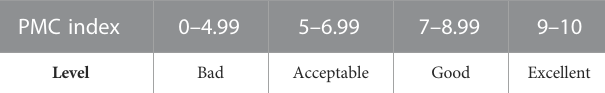
TABLE 4 Evaluation criteria of PMC